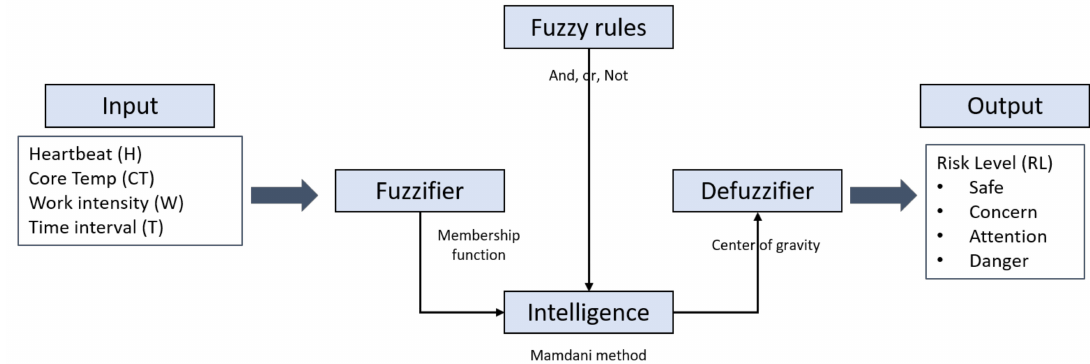
Figure 7. Fuzzy implementation